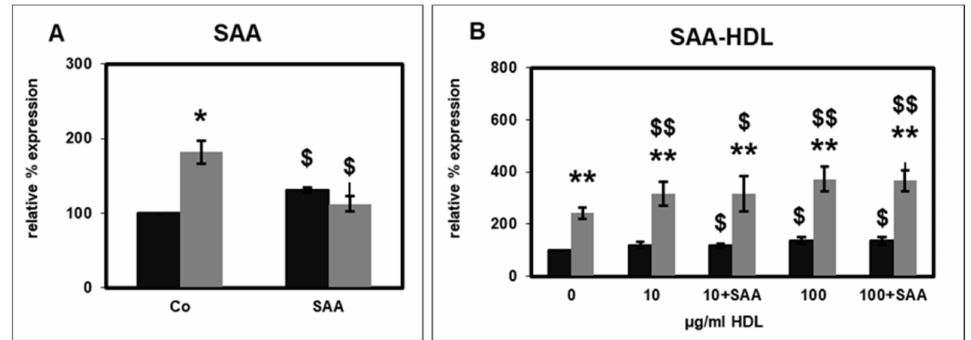
Figure 2. Effect of serum amyloid A protein (SAA) at a final concentration of 10 µ g/mL (( A ); n = 3) and of HDL isolated from healthy subjects (HS-HDL) and HS-HDL spiked with SAA (+) at final concentrations of 10 µ g/mL and 100 µ g/mL (( B ); n = 8) on the basal (black bars) and fMLP-stimulated (grey bars) CD14 surface expression. The percentage of CD14 positive cells in the absence of SAA and fMLP (Co: buffer as control, 0 µ g/mL HDL) was set as 100%. * p < 0.05 and ** p < 0.01 versus unstimulated values; $ p < 0.05, $$ p < 0.01 versus control (Co: 0.01% bovine serum albumin) for A, versus 0 µ g/mL HDL for B; data shown are mean values ± standard error of the mean (SEM).